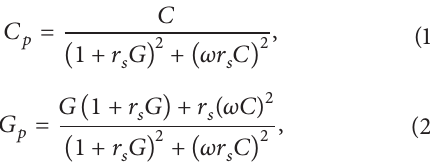
Figure 7: Parallel mode 𝐶 𝑝 - 𝑉 and 𝐺 𝑝 - 𝑉 characteristics for several channel thicknesses 𝑡 GDS GDS ( 80 × 8 𝜇 m 2 = 6.4 × 10 −6 cm 2 ). (a) Capacitance ( 𝐶 𝑝 ) measured at 100kHz. (b) Conductance ( 𝐺 𝑝 ) measured at 100kHz. (c) Capacitance ( 𝐶 𝑝 ) measured at 1MHz. (d) Conductance ( 𝐺 𝑝 ) measured at